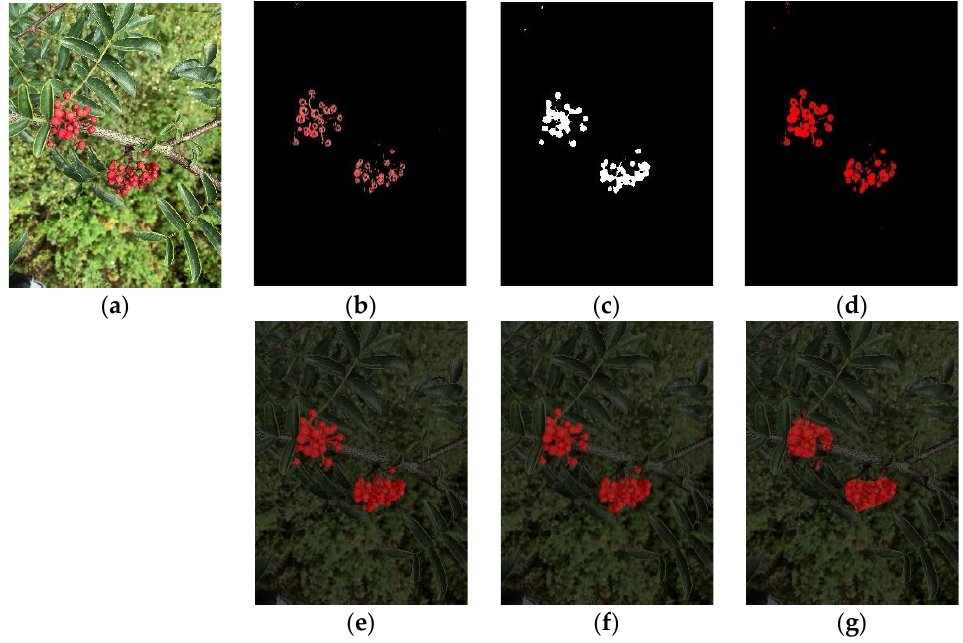
Figure 13. ( a ) Multiple front-lit clusters without occlusion; ( b ) results from RGB algorithm for segmentation; ( c ) results from HSV algorithm for segmentation; ( d ) results from k-means algorithm for segmentation; ( e ) results from U-Net algorithm for segmentation; ( f ) results from DeepLabV3+ algorithm for segmentation; ( g ) results from PSPnet algorithm for segmentation. Table 1. Comparison of IOU for traditional image segmentation methods.